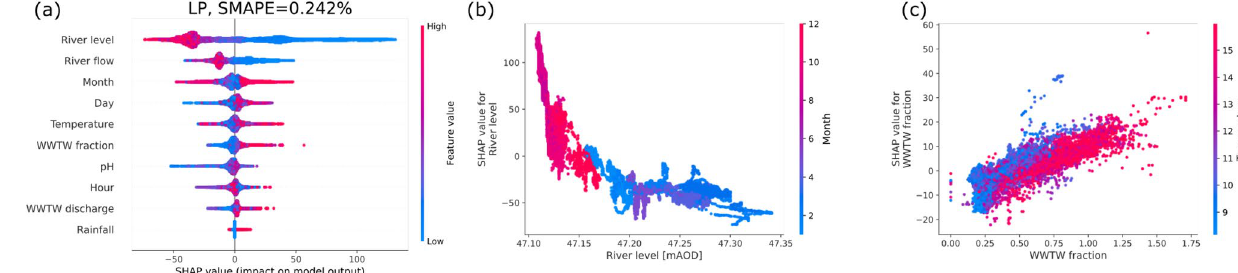
Figure 11. Feature ranking and partial dependency plots of the extended EC model at the LP site. We plot the feature ranking ( a ), the most important feature ( b ) and the dependency on the fraction of flow from the WWTW ( c ). Note that surface water-groundwater exchange in the river between the WWTW and gauging station site can lead to a value for WWTW fraction > 1 .